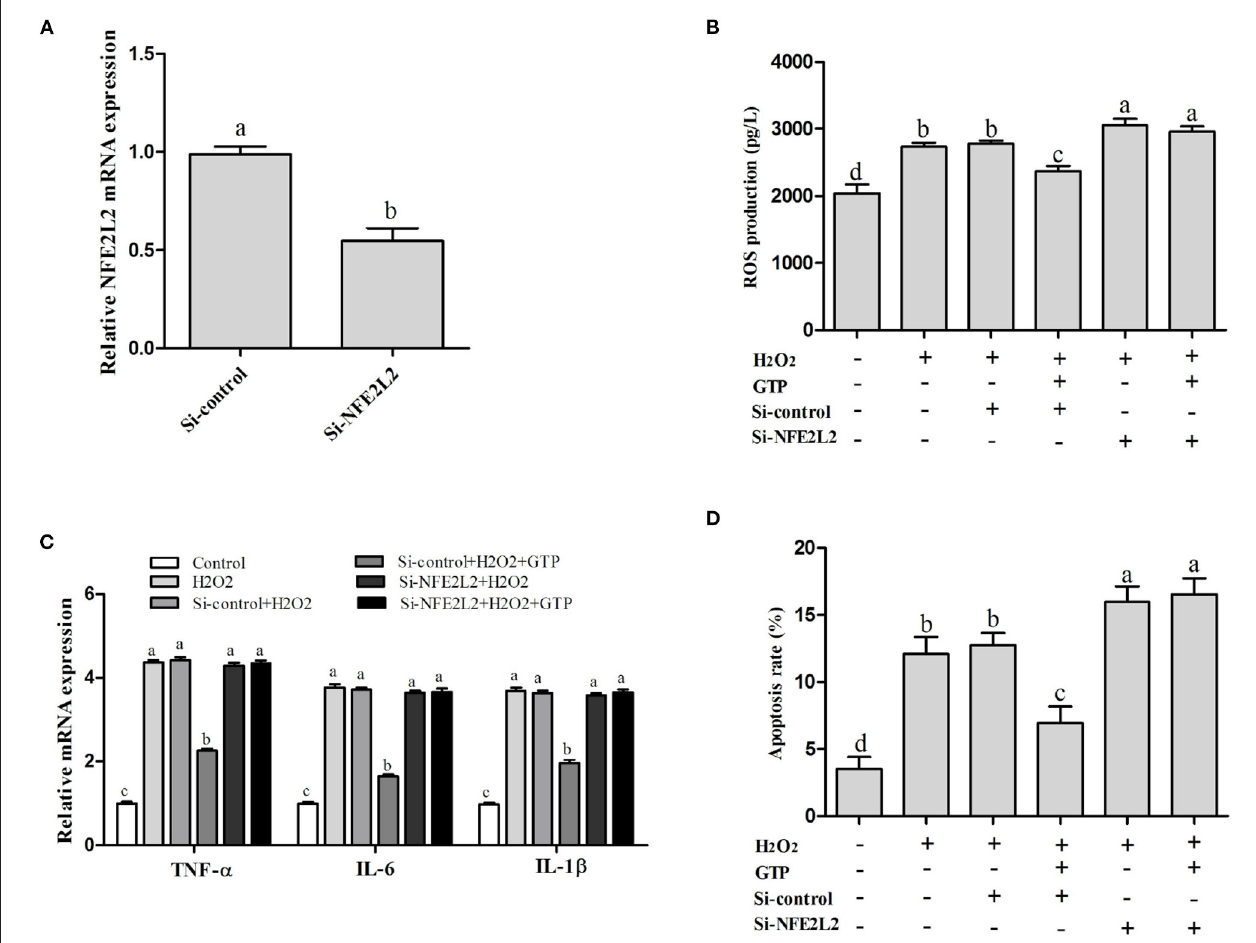
FIGURE 8 | Knockdown of NFE2L2 attenuated the beneficial effects of GTP on H 2 O 2 -induced oxidative injury. (A) NFE2L2 mRNA level (B) ROS level; (C) TNF- α , IL-6, and IL-1 β mRNA levels; and (D) the apoptosis rate of BMECs. a,b,c,d, the adjacent lowercase letters indicate significant difference, the alternate lowercase letters indicate extremely significant difference, and the same lowercase letters indicate insignificant